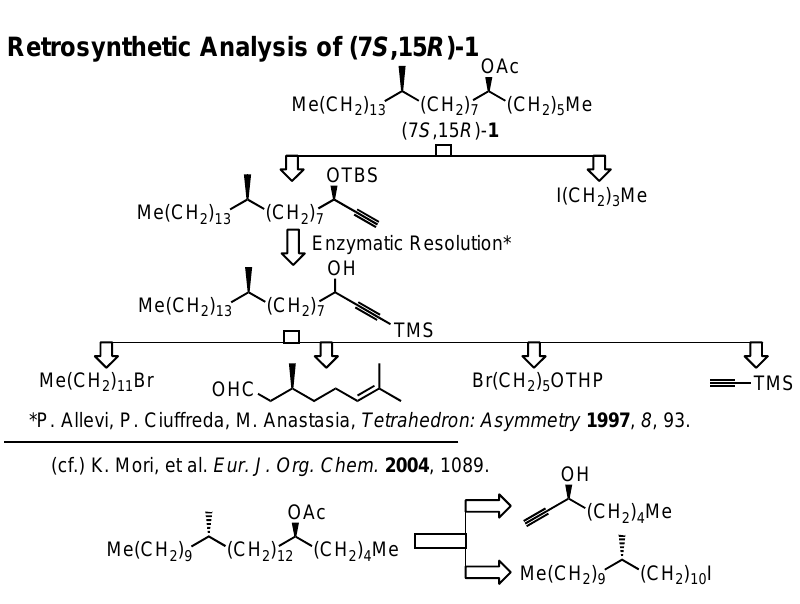
Retrosynthetic Analysis of (7 S ,15 R